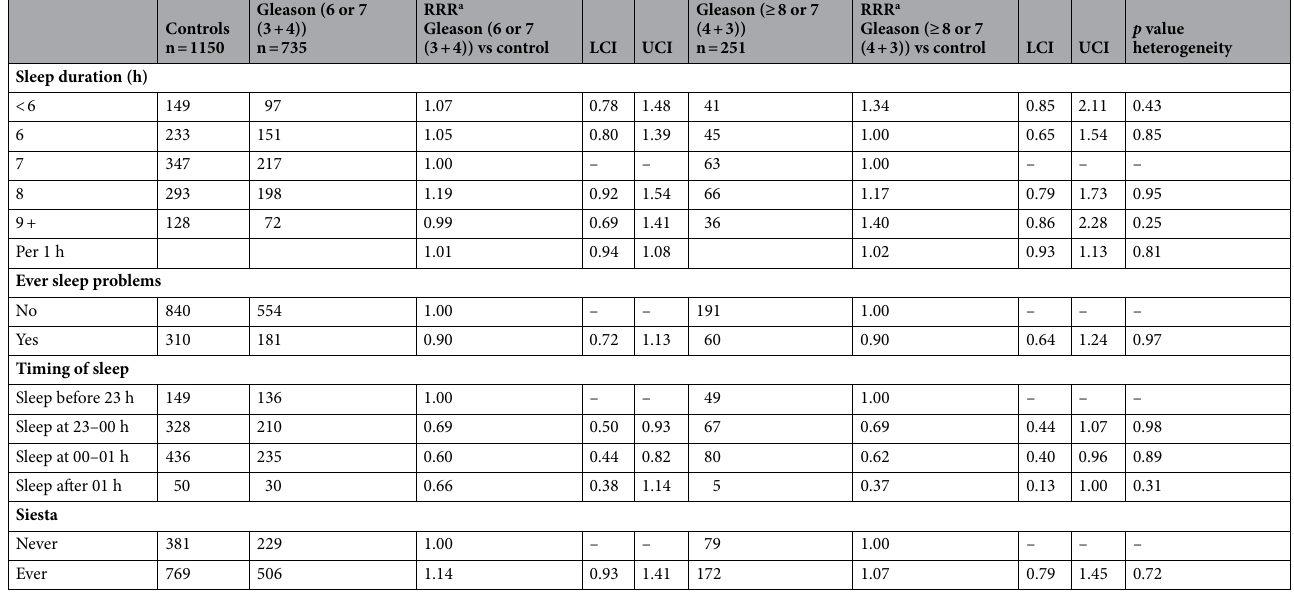
Table 4. Associations of selected habitual sleep characteristics and prostate cancer risk by sub-phenotype, MCC-Spain, 2008–2013. Note the sum does not equal the total due to missing data. a Models adjusted for age, centre, education, socioeconomic status, cigarette smoking status, family history of prostate cancer in first degree relatives, BMI, physical activity, alcohol consumption. Categories for missing values were created for family history of prostate cancer in first degree relatives and alcohol consumption. Significant values are in